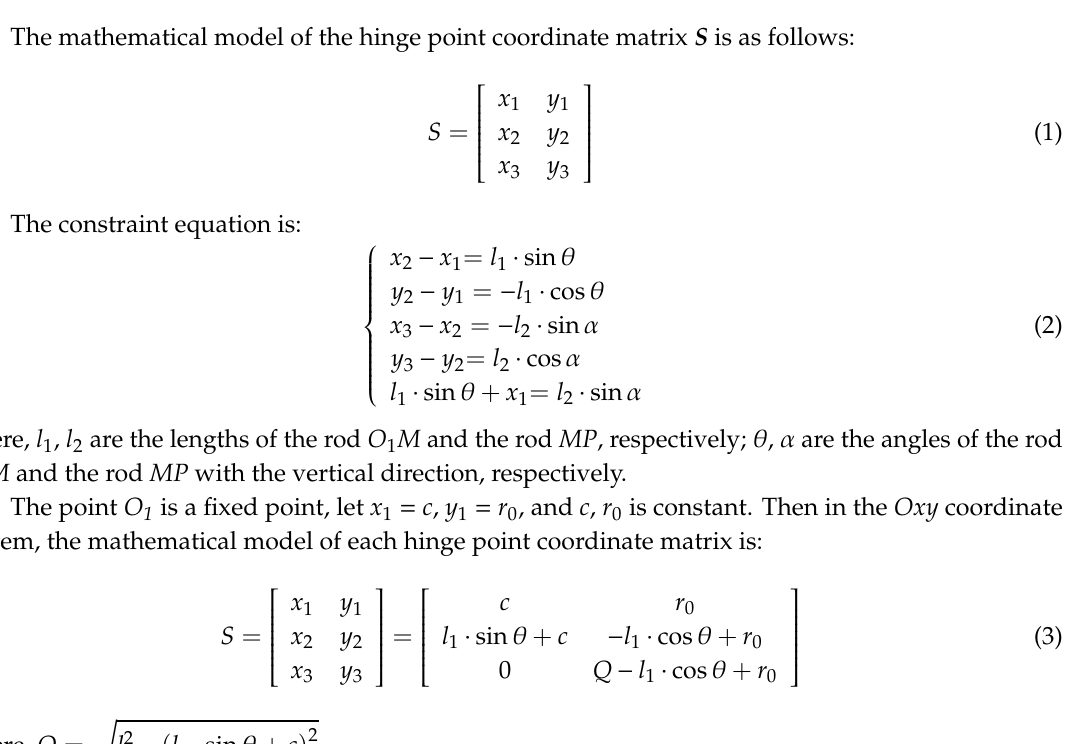
Figure 4. Kinematics analysis of the expanding arm.